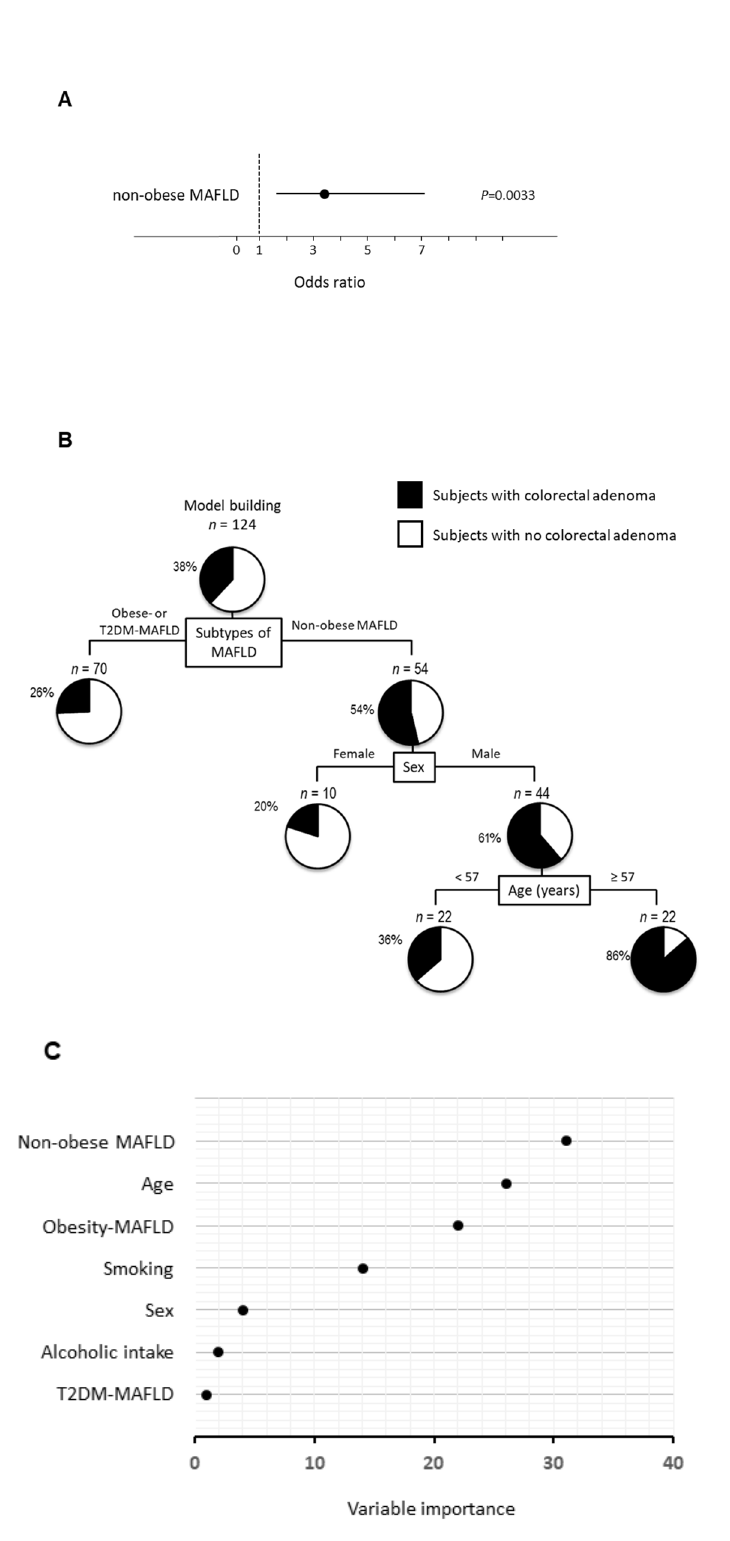
Figure 3. Independent factors and profiles associated with the presence of colorectal adenoma according to subtypes of MAFLD. ( A ) Independent factors for the presence of colorectal adenoma analyzed by logistic regression analysis, ( B ) profiles for the presence of colorectal adenoma analyzed by decision-tree analysis. The pie graphs indicate the proportion of patients with colorectal adenoma (black) and patients with no colorectal adenoma (white), ( C ) distinguishing factors for the presence of colorectal adenoma analyzed by random forest analysis. The relative contributions of each variable to the presence of colorectal adenoma is expressed by variable importance.